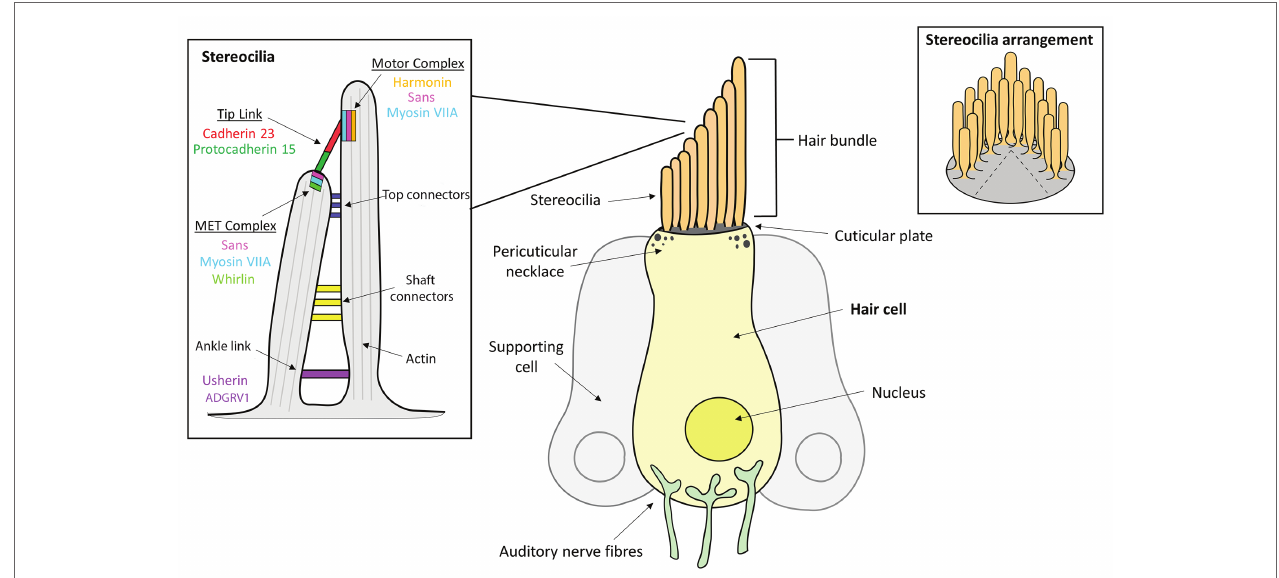
FIGURE 1 | Inner ear hair cell (HC) structure showing the locations of several Usher syndrome (USH) proteins. The apical side of each hair cell expresses a bundle of highly-organized, actin-filled stereocilia, in which the mechanotransduction takes place. The stereocilia are held together by transient ankle links at their base, horizontal shaft links along their length, horizontal tip links near the top and diagonal tip links at their